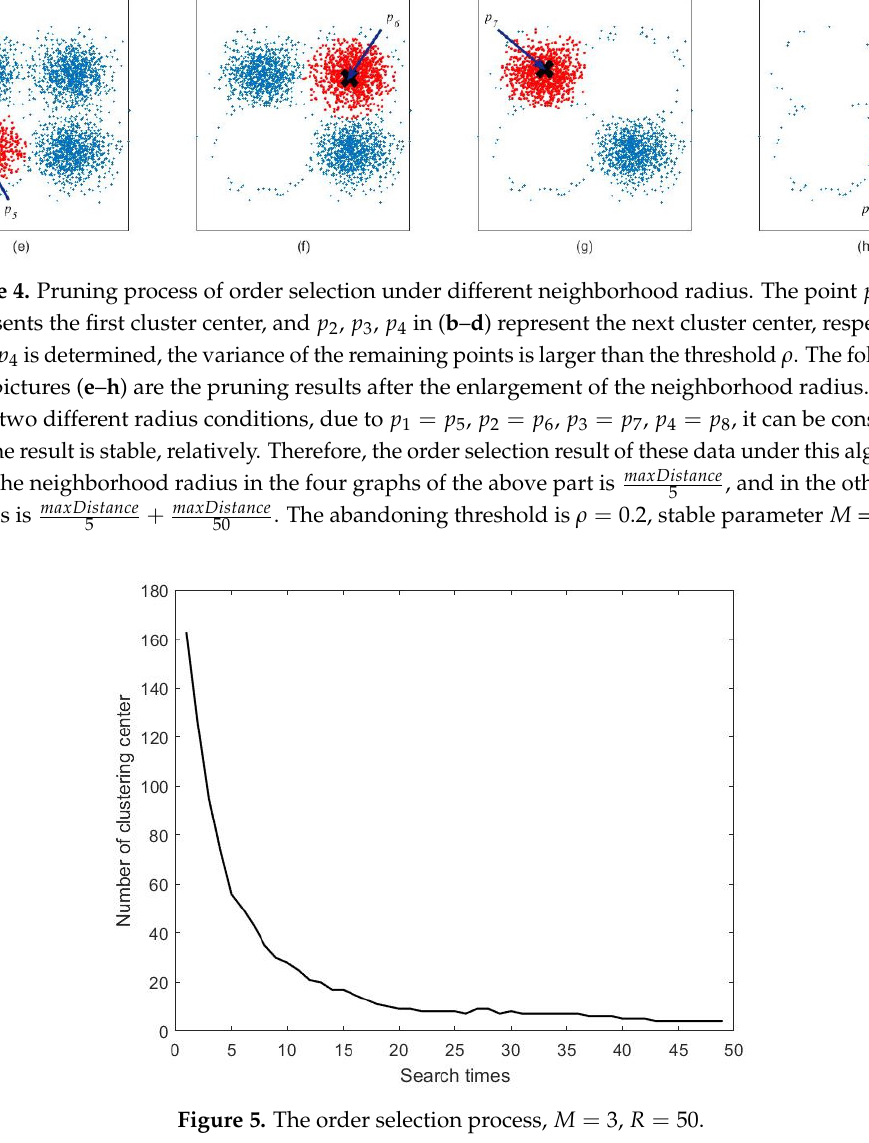
Figure 5. The order selection process, M = 3, R =